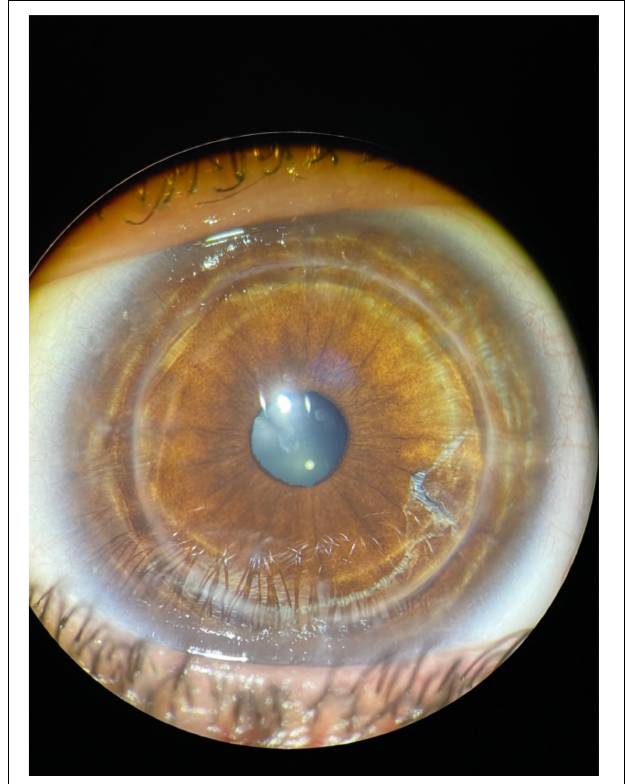
FIGURE 3 | Fifteen months postoperative anterior segment